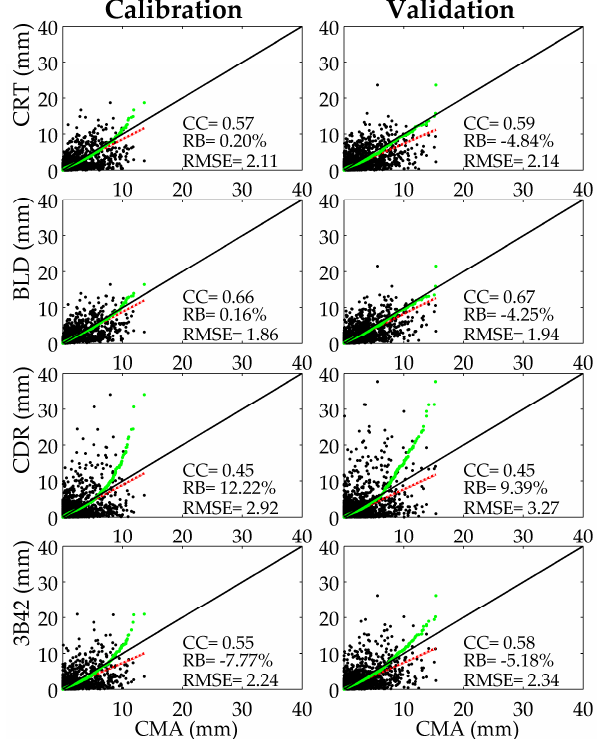
Figure 4. Q-Q plots (green) and scatterplots (black) of basin averaged precipitation from SGPEs against CMA for both calibration (2001–2005) and validation (2006–2012) periods. CMA for both calibration (2001–2005) and validation (2006–2012)